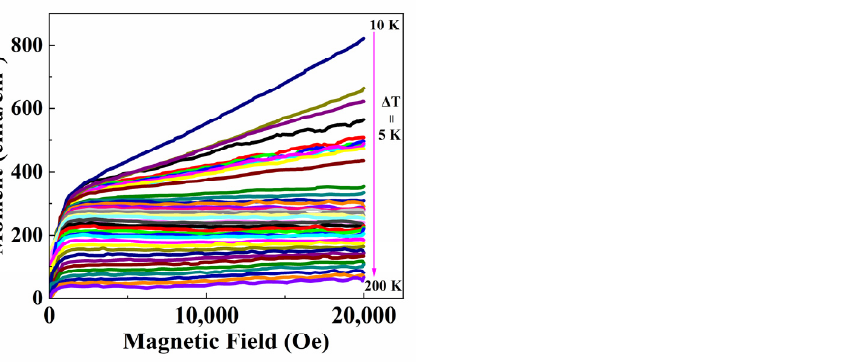
Figure 6. The isothermal magnetization M(H, T) curves with the applied field from 0 to 20,000 Oe measured from 10 to 210 K (with temperature intervals of 5 K) for PSMO film on SrTiO 3 . The M(H, T) curves were corrected by deducting the diamagnetic background induced by the SrTiO 3 substrate. Figure 7 shows the Arrott plots obtained from M(H, T) as the M 2 vs. H/M are plotted to investigate the phase transition types. The shapes of M(H, T) curves at around T C indicate a typical second-order transition, as found in La 1-x Ba x MnO 3 manganite [16].